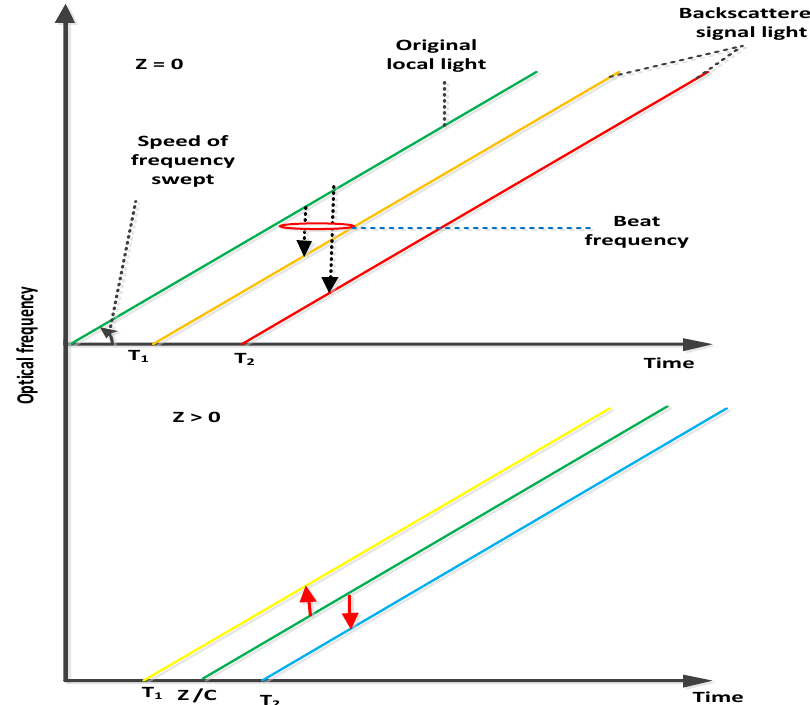
Figure 2. Relative distance